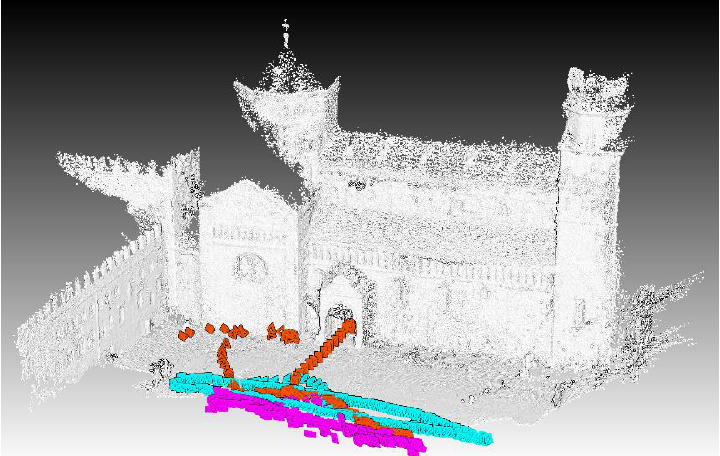
Figure 5: The shaded dense point cloud of the Piazza Duomo dataset. The position and orientation of the extracted frames are shown in different colours to indicate the device they were acquired from (Table 1).